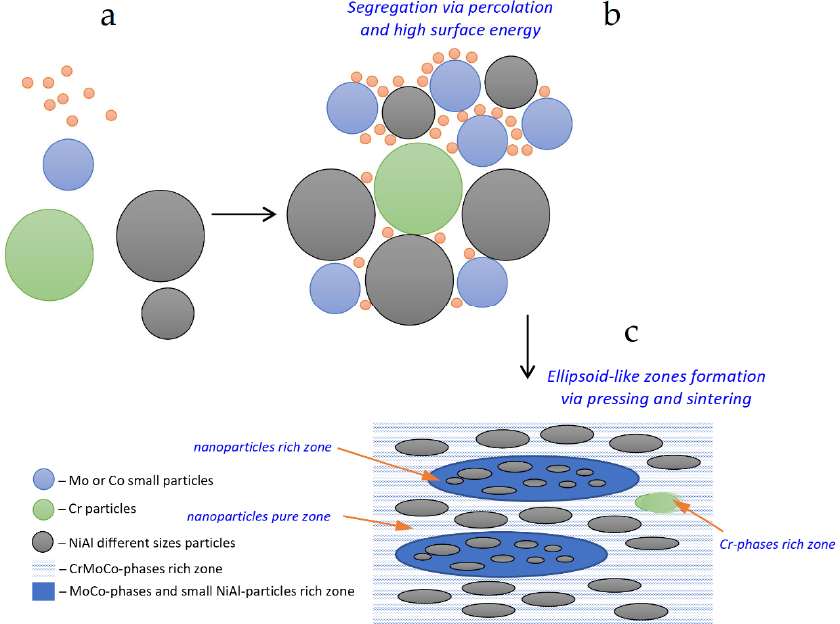
Figure 9. Illustration of the Segregation mechanisms of particles with different diameters during mixing: ( a ) adhesion of smaller particles to “medium” particles, ( b ) segregation of “coated” particles and larger particles, ( c ) formation of elliptical zones with fine grains enriched in cobalt and molybdenum.